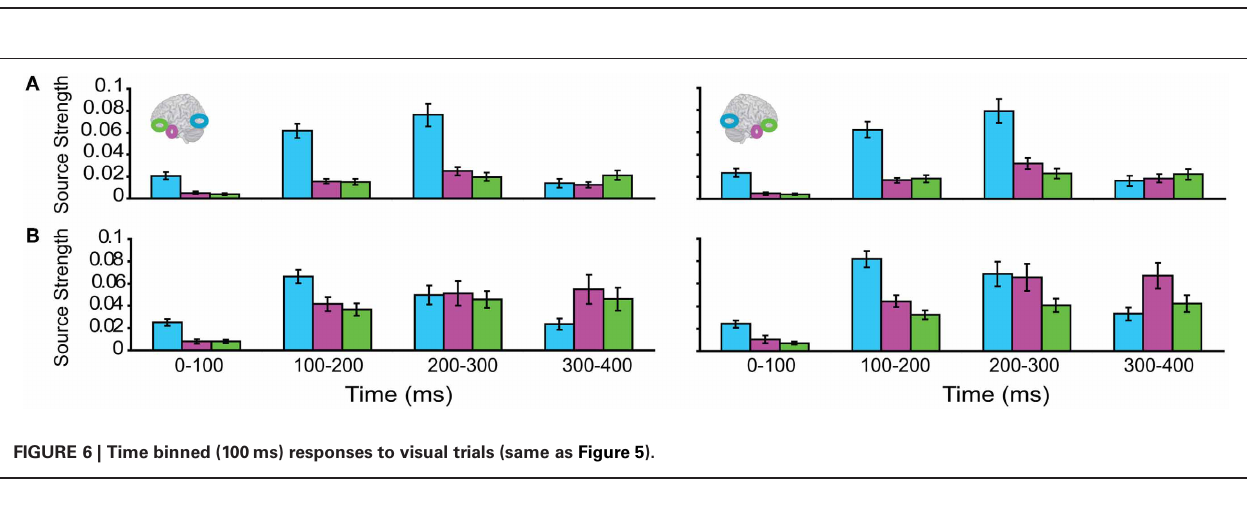
FIGURE 5 | Regional response waveforms to visual trials, averaged across participants, during (A) the Vscrambled trials, presenting phase-scrambled visual images, and (B) the Vobject trials, presenting two object (s) parts.